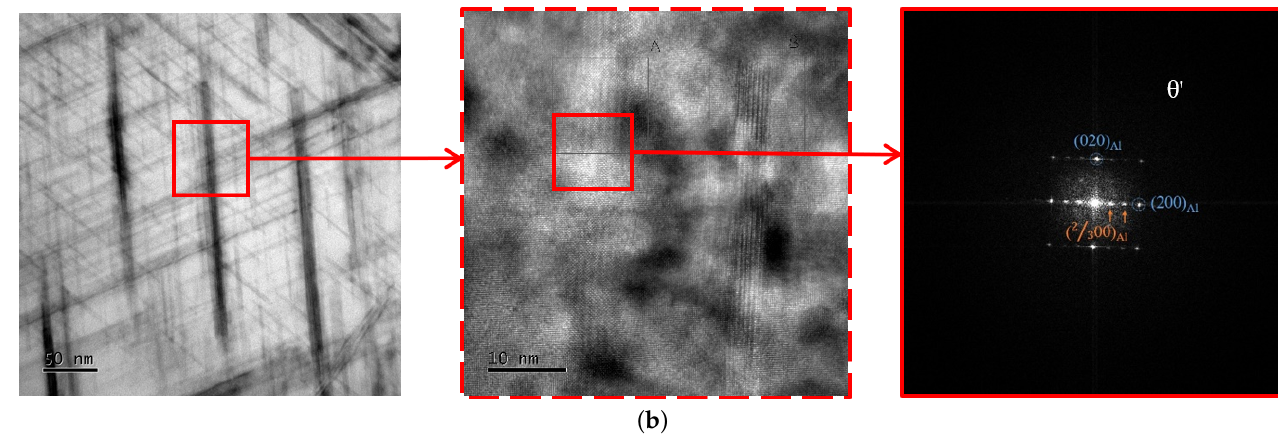
Figure 8. TEM and corresponding HRTEM images and fast Fourier transform (FFT) patterns of selected intragranular precipitates in ( a ) CHT-PA sample with identified θ ’ precipitates and ( b ) DCT- PA sample with identified θ ’ precipitates. The electron beam is parallel to [001] Al axis.